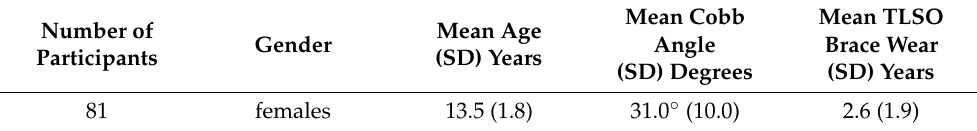
Table 1. Participants’ demographic and clinical